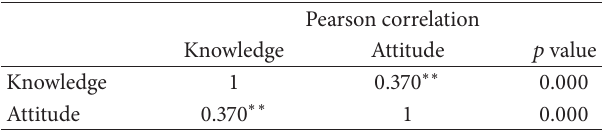
Table 8: Degree of relationship between the knowledge and attitude of the obstetrics care